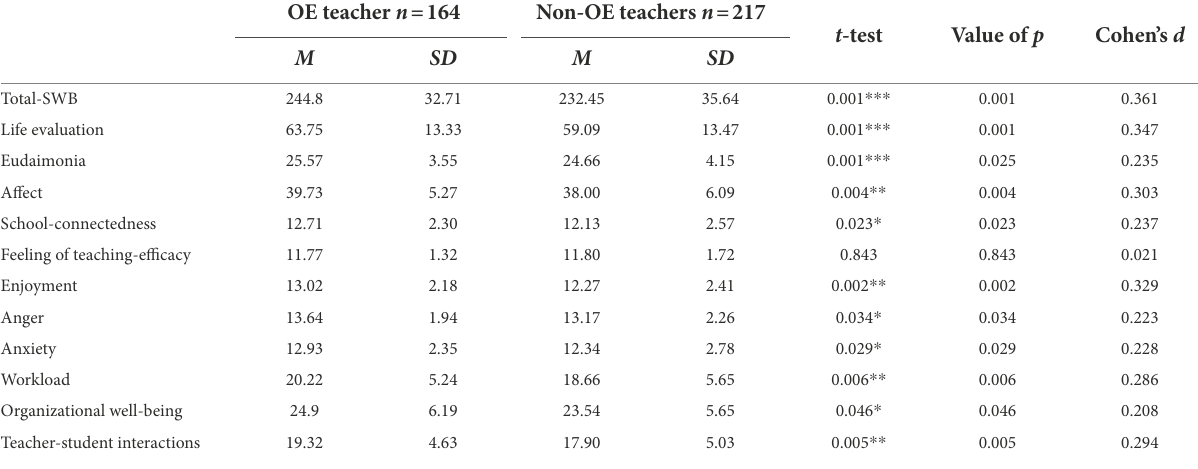
TABLE 2 OE and non-OE teachers’ SWB scores